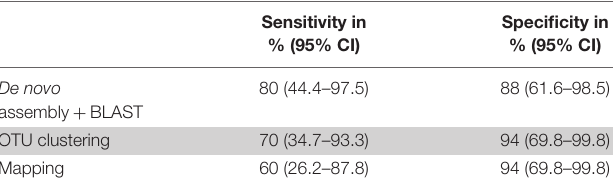
TABLE 3 | Sensitivity and specificity for all three data analysis approaches ∗